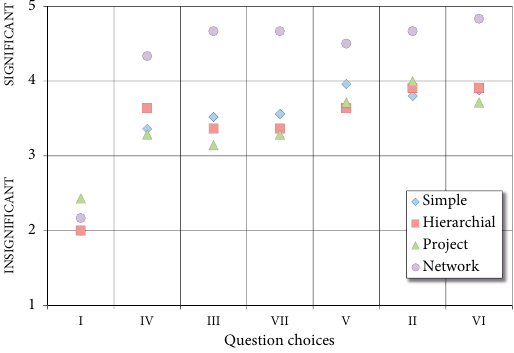
Fig. 8. Significance of internal business factors according to organizational Table 2. Numbers of Responses and p-values from One-Way ANOVA Analysis about the External Business Factors That Affect the Marketing Activities External business factors